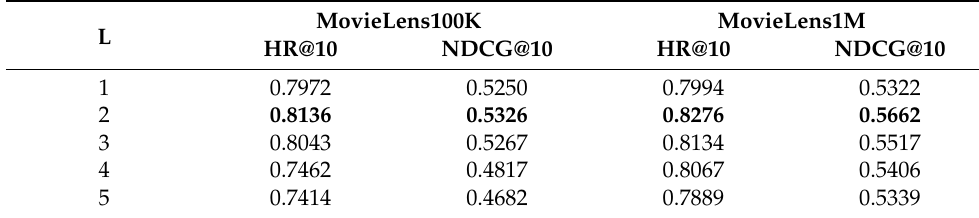
Table 11. The impact of hidden layer depth of